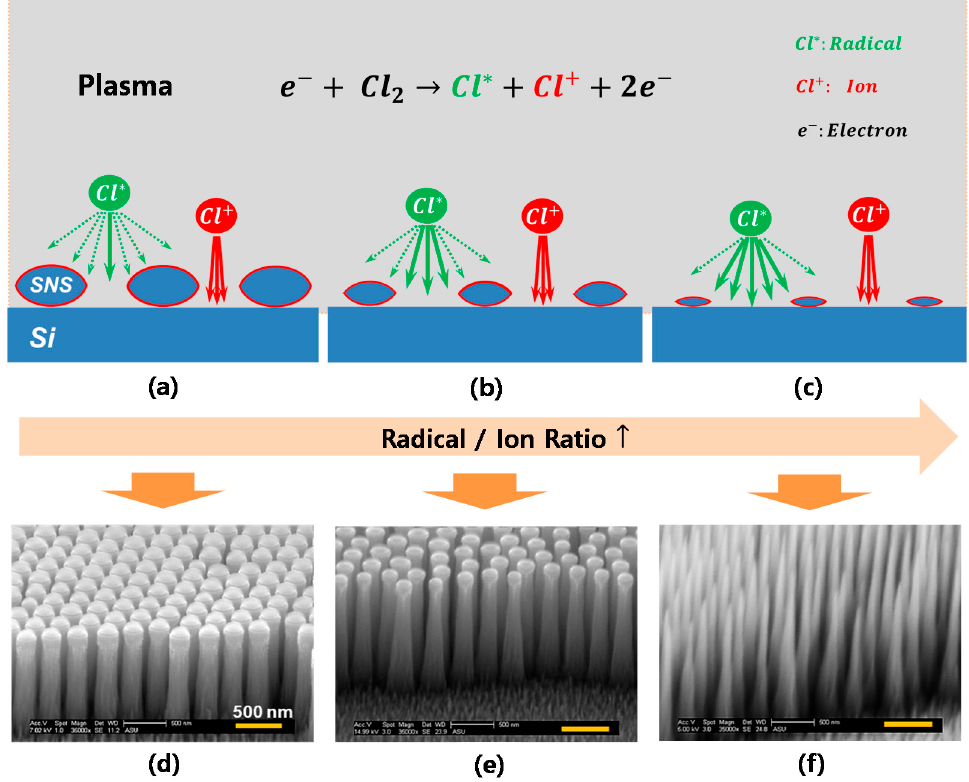
Figure 4. ( a – c ) Schematic illustration of radicals and ion angular distributions and radical/ion flux ratio change with SNS mask changes and ( d – f ) illustration of fabricated Si nanopillars (NPs) and nanotips (NTs) after 10-min Cl 2 etching.